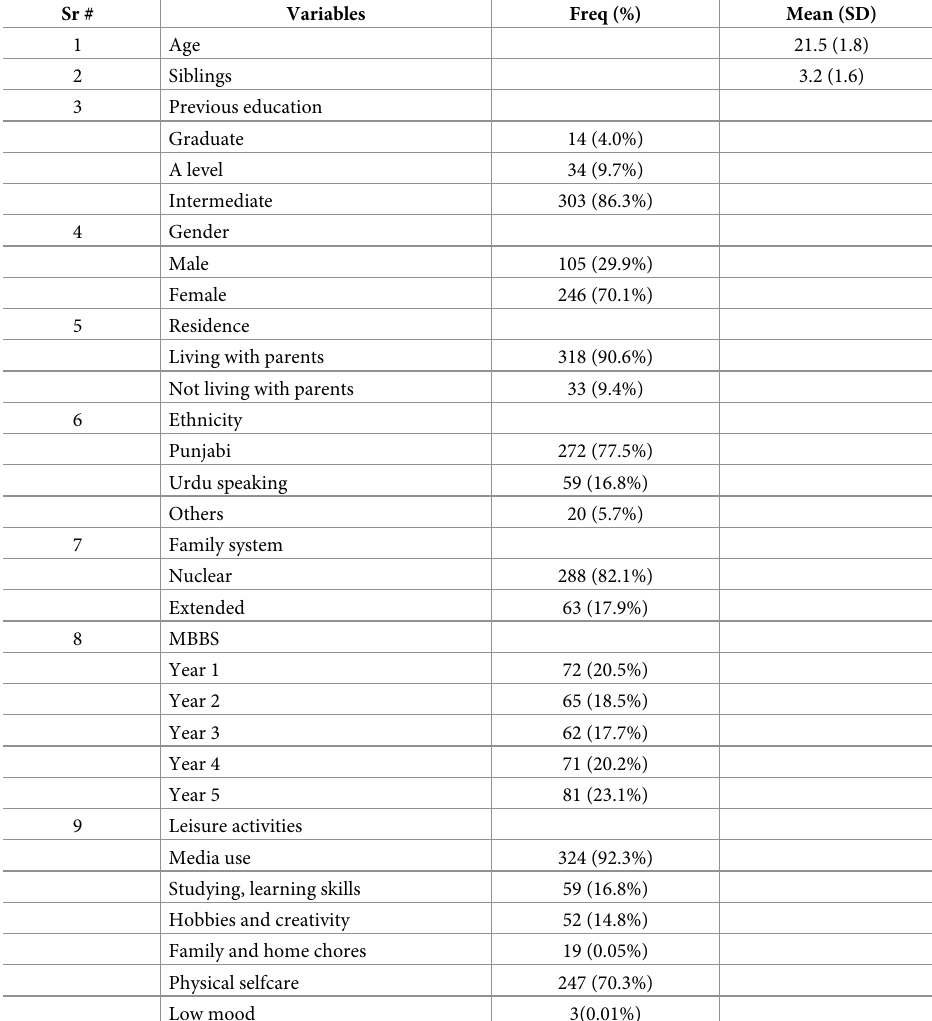
Table 1. Demographic characteristics of the undergraduate medical